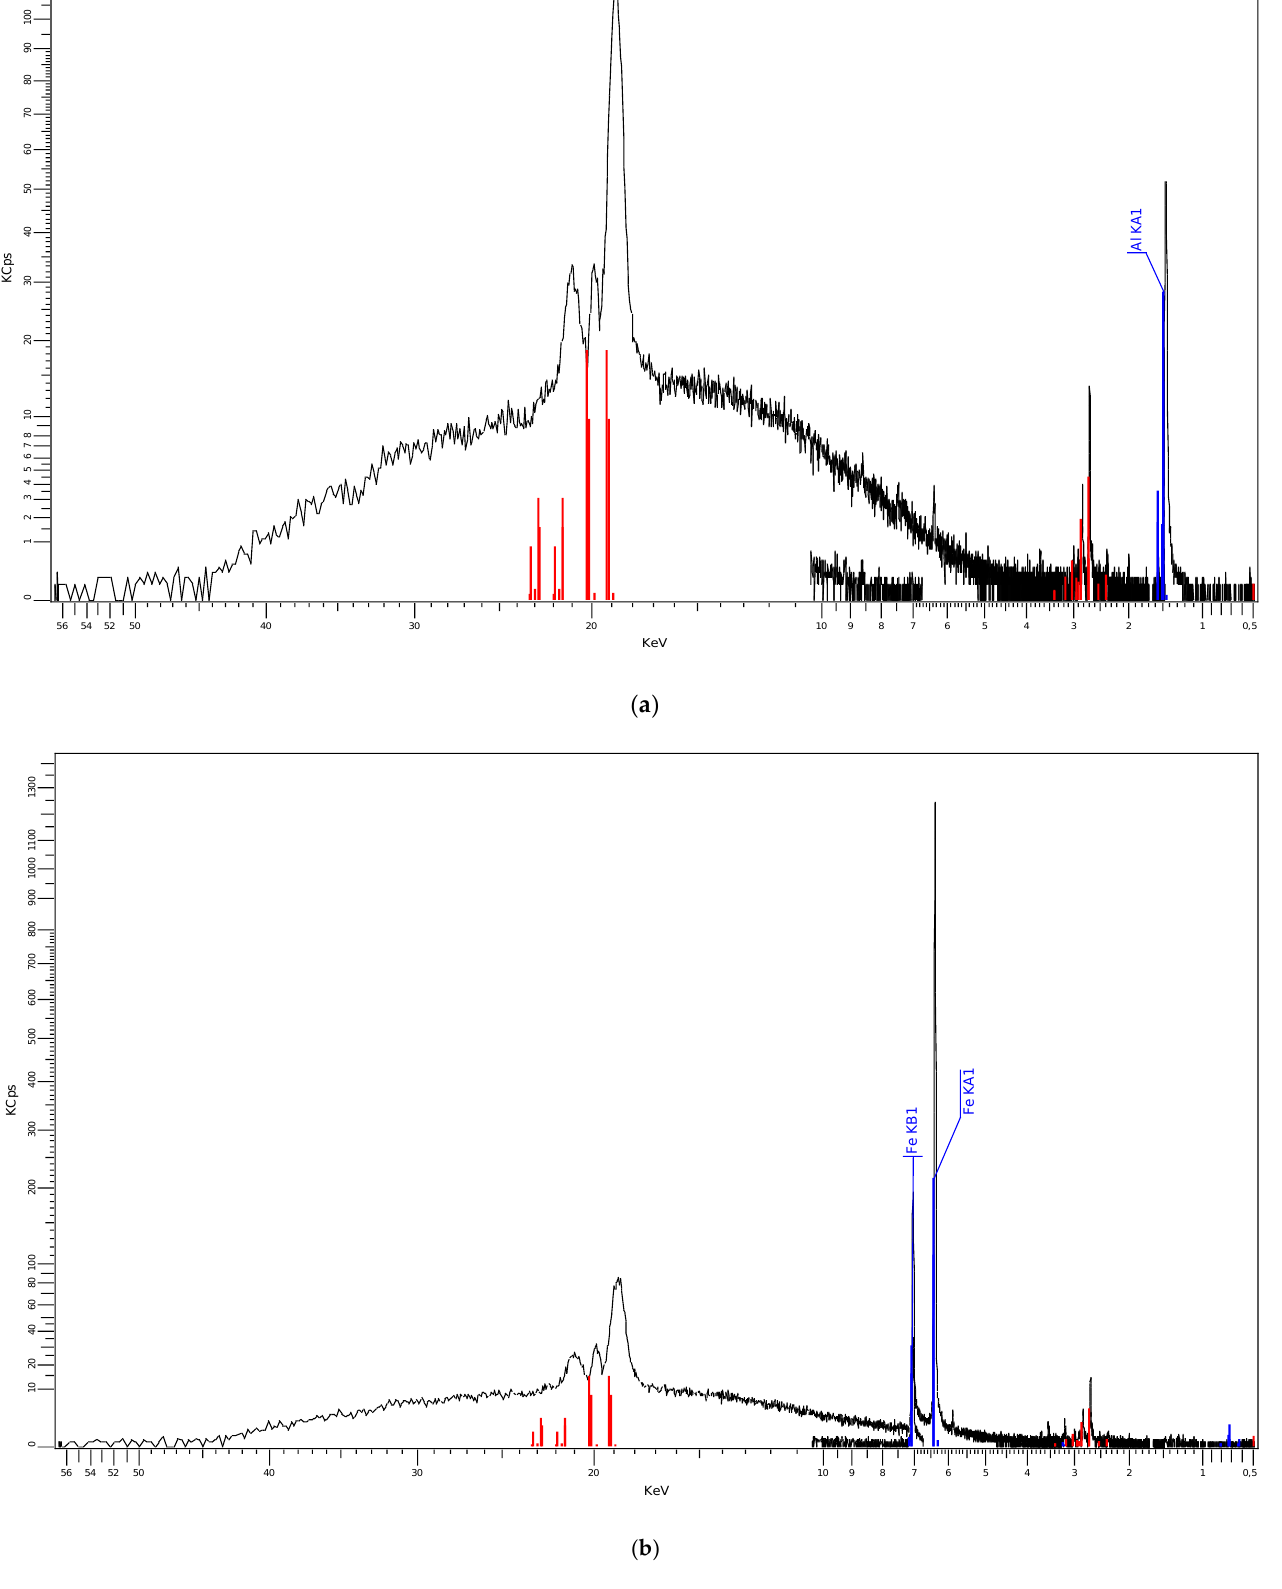
Figure 12. XRF characteristics, 7% mass ratio; ( a ) Al fillers in LDPE matrix, ( b ) Fe fillers in LDPE matrix.